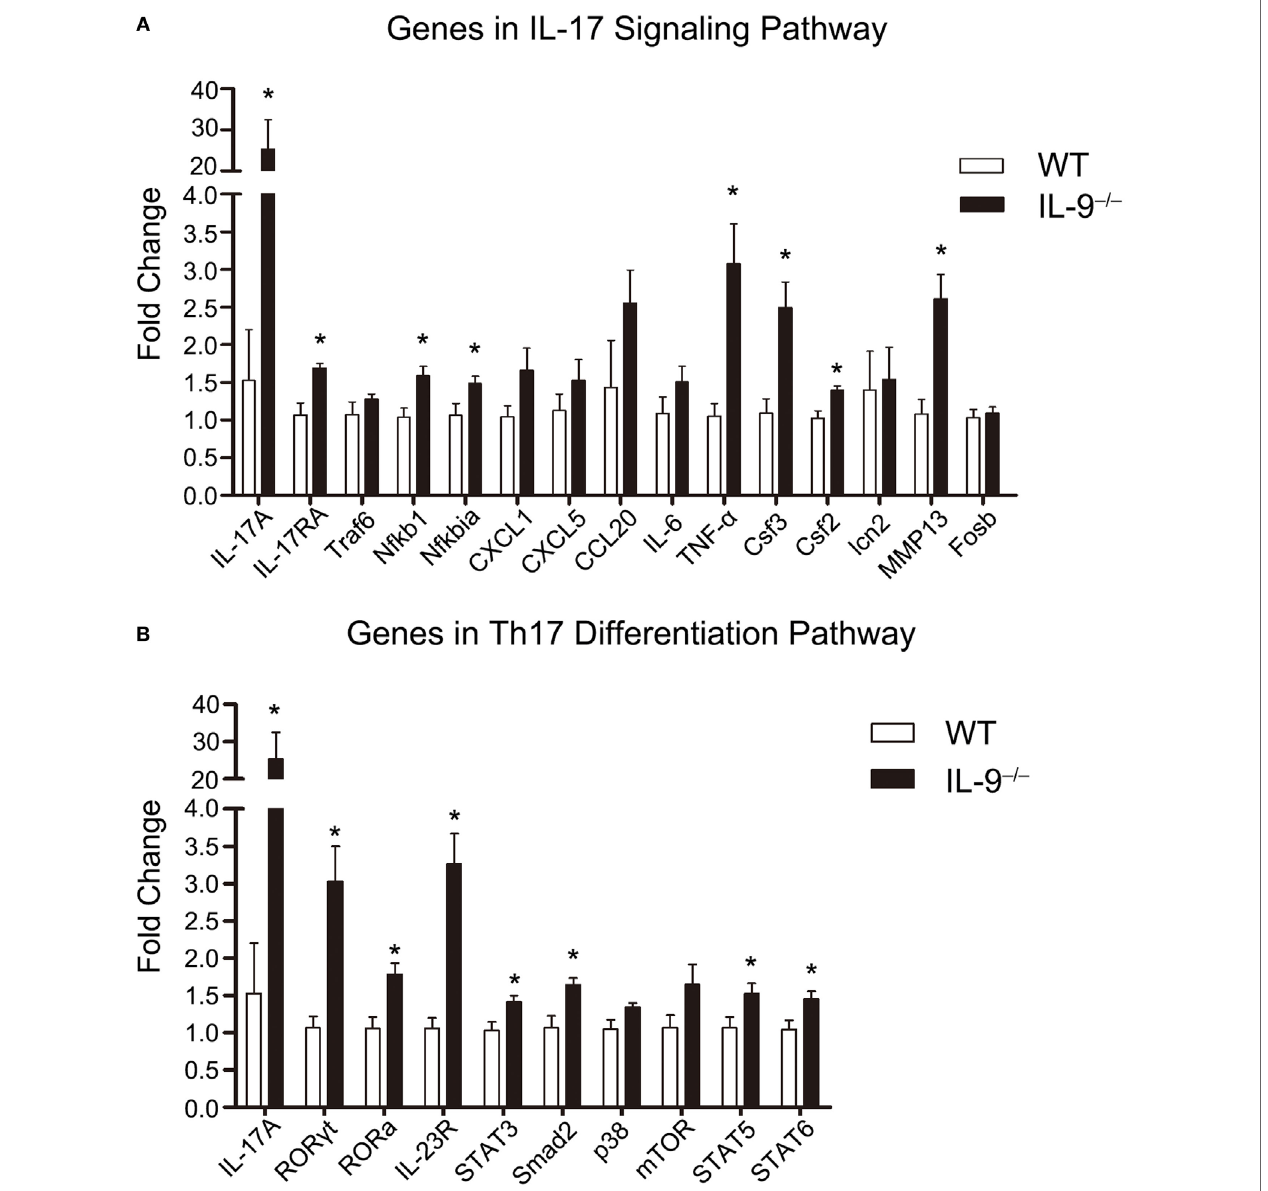
FigUre 4 | T-helper (Th)17/IL-17-related genes expression was upregulated in lungs of IL-9 ‒ / ‒ PCP mice. The whole-lung RNA was extracted from WT and IL-9 ‒ / ‒ mice at 3-week postinfection. The genes which are related to IL-17 signaling pathway (a) and Th17 differentiation pathway (B) were detected through real-time PCR for mRNA expression between the two groups. The fold change was figured out using the 2 −ΔΔ CT normalized to GAPDH. Reactions were performed in triplicate for n = 5–7 samples per group. Data were presented as mean ± SEM and the graphs were representative of three independent experiments. * P < 0.05 compared to WT group by Student’s t